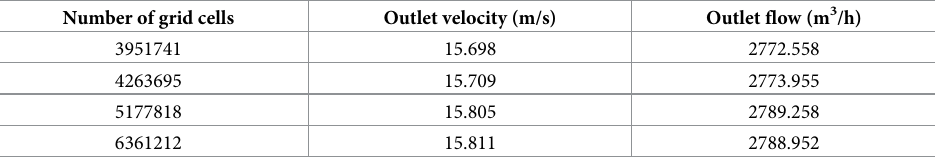
Table 1. Fluid grid independence test